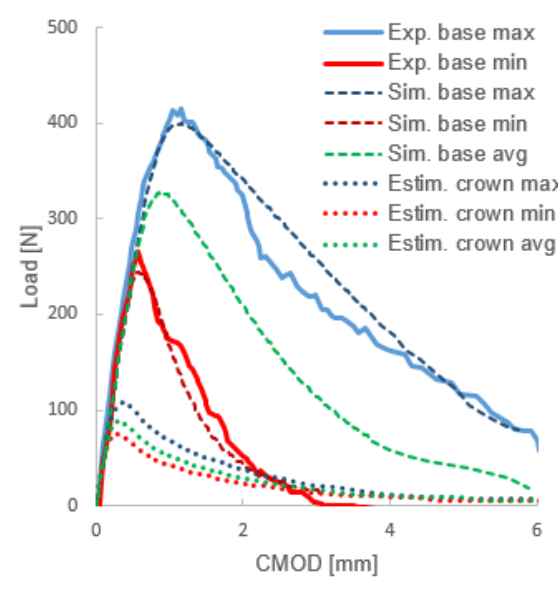
Figure 2. Load vs. CMOD responses of CT speci- mens cut from arch base and crown: (i) experimental (Exp.), (ii) numerically simulated by means of sequen- tially linear approach to inverse analysis (Sim.) and (iii) estimated by trial-and-error approach to inverse analysis